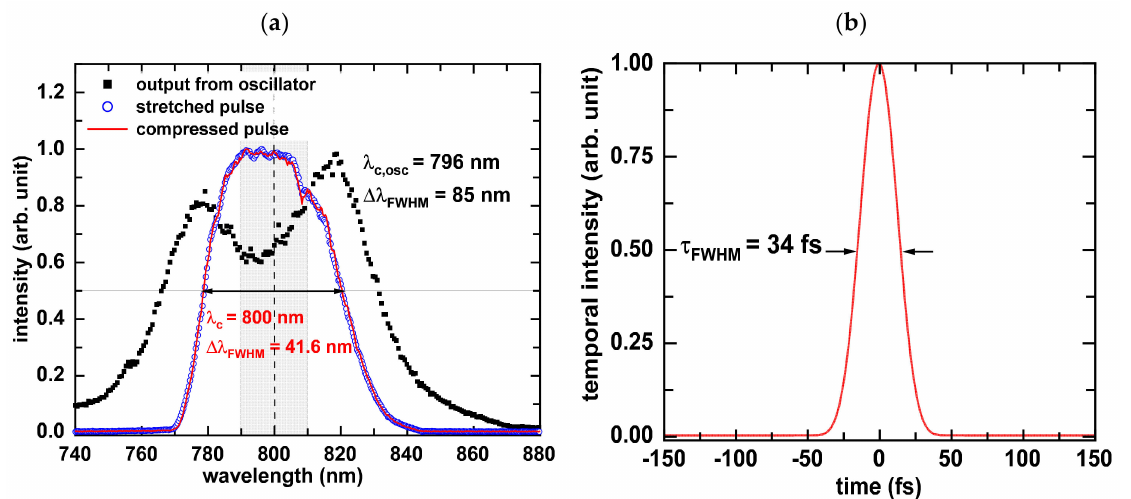
Figure 5. ( a ) Spectra of the laser pulse from the oscillator (black squares), the amplified stretched pulse after the 4-pass amplifier (blue circles) and the compressed laser pulse (red line). ( b ) Temporal intensity profile after compression, showing a pulse duration of 34 fs